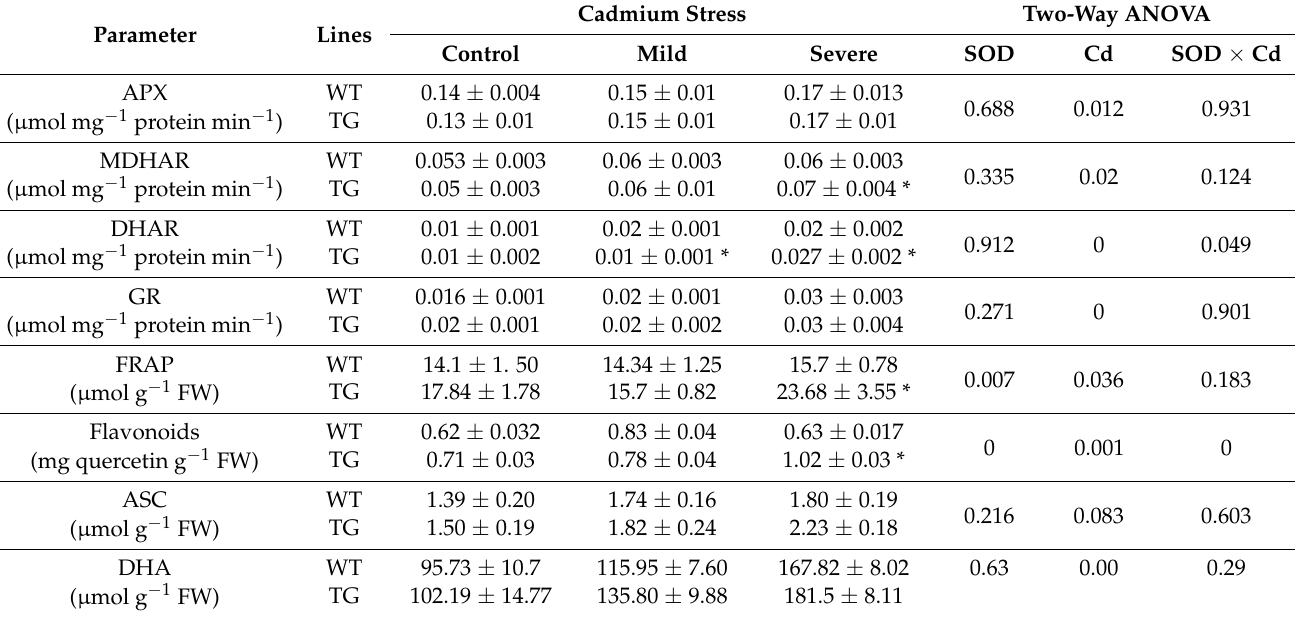
Table 4. Effect of Cd-stress on the antioxidant defense of the FeSOD overexpressing maize transgenic line (TG) and its wild type